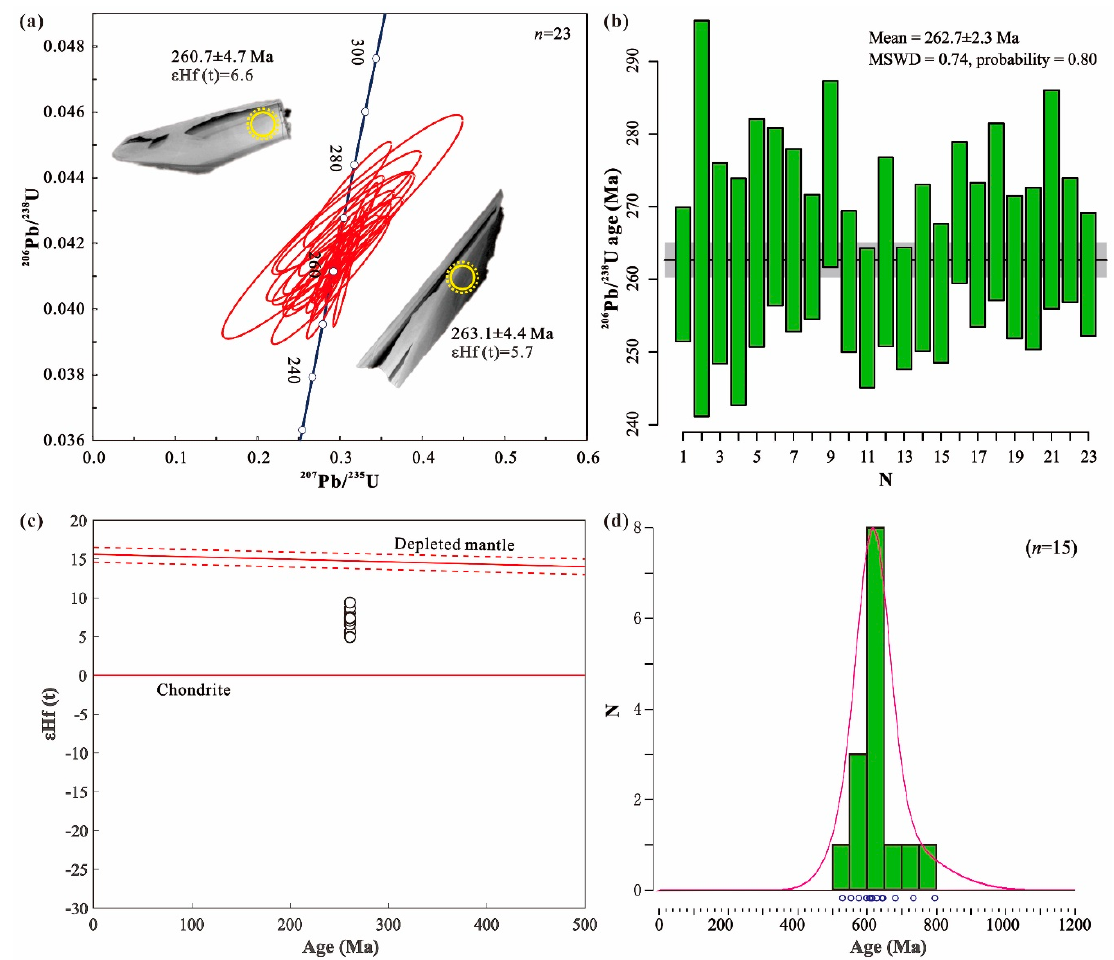
Figure 4. The diagrams for zircon U-Pb-Hf isotopes of the hornblende gabbro from the Baogeqi gabbro pluton: ( a ) Representative zircon cathodoluminescence images and U-Pb concordia dia- gram; ( b ) Weight mean plot of the concordant ages; ( c ) Plot of zircon ε Hf(t) values vs. U-Pb ages; ( d ) Histograms of T DM1 model ages of zircons.